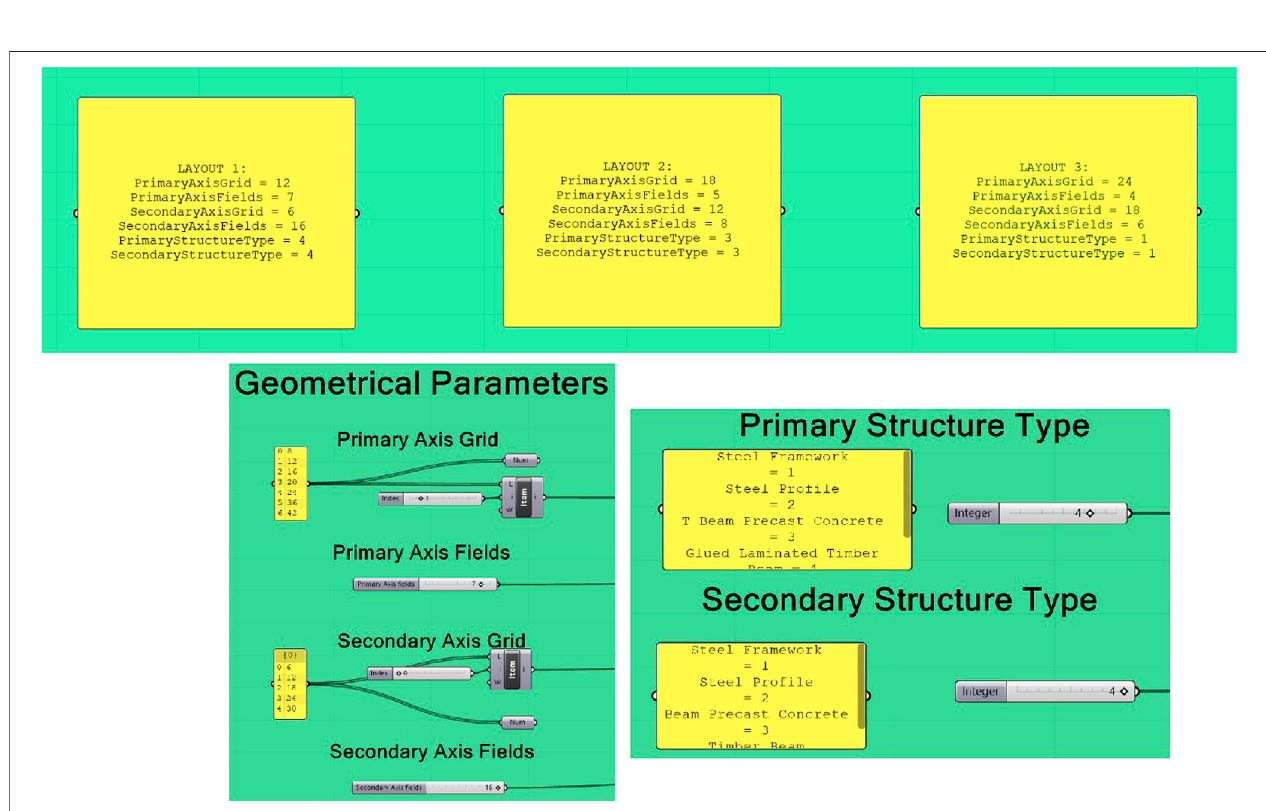
FIGURE 11 | Instructions embedded into the Grasshopper script and slider-based interaction during the desktop-based part of the evaluation.